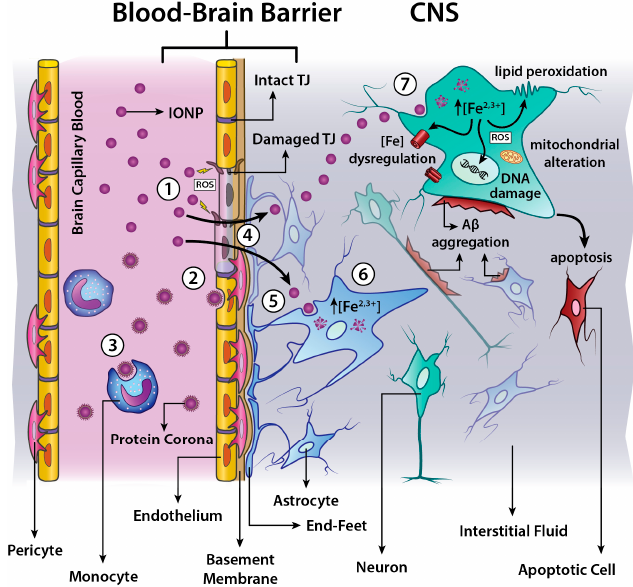
Figure 10. Interference of IONPs with CNS iron homeostasis and its involvement in neurodegeneration process. (1) IONPs in the bloodstream can alter the permeability of BBB. The integrity of BBB can be damaged by ROS production and/or inhibition of Occludin-proteins (belonging to tight junctions proteins TJ); (2) based on their size, surface charge and coating IONPs are subject to the formation of protein corona around IONPs, leading to opsonization phenomena. This can alter physicochemical properties of IONPs and/or improve transport across BBB; (3) IONPs can be also eliminated from blood circulation by means of recognition and uptake by monocytes or other cells of Mononuclear Phagocytic System; (4) IONPs can cross BBB by means of paracellular or transcellular mechanism and enter in CNS [6]; (5) according to their size, IONPs can be internalized by pinocytosis (dimensions < 10 nm) or endocytosis (approximatively larger than 10 nm) into the CNS cells; (6) in the intracellular environment IONPs are degraded in the acid environment of endosomes (degradation time depending on IONP size) with consequent release of iron ions in the cytoplasm; astrocytes are more sensitive to uptake and accumulation of IONPs [111]; (7) in the neurons, after the IONPs internalization and degradation, iron ions participate to redox cycling taking part to many biological processes implicated in neurodegeneration and neural damage: (a) Fenton’s reaction with production of ROS (consequent lipid peroxidation and/or DNA damage); (b) alteration of iron regulation proteins (responsible for iron transport, uptake and storage); (c) alteration of mitochondrial activity; (d) accumulation in iron pool; (e) apoptosis; and (f) protein aggregation (e.g., A β , α -synuclein)